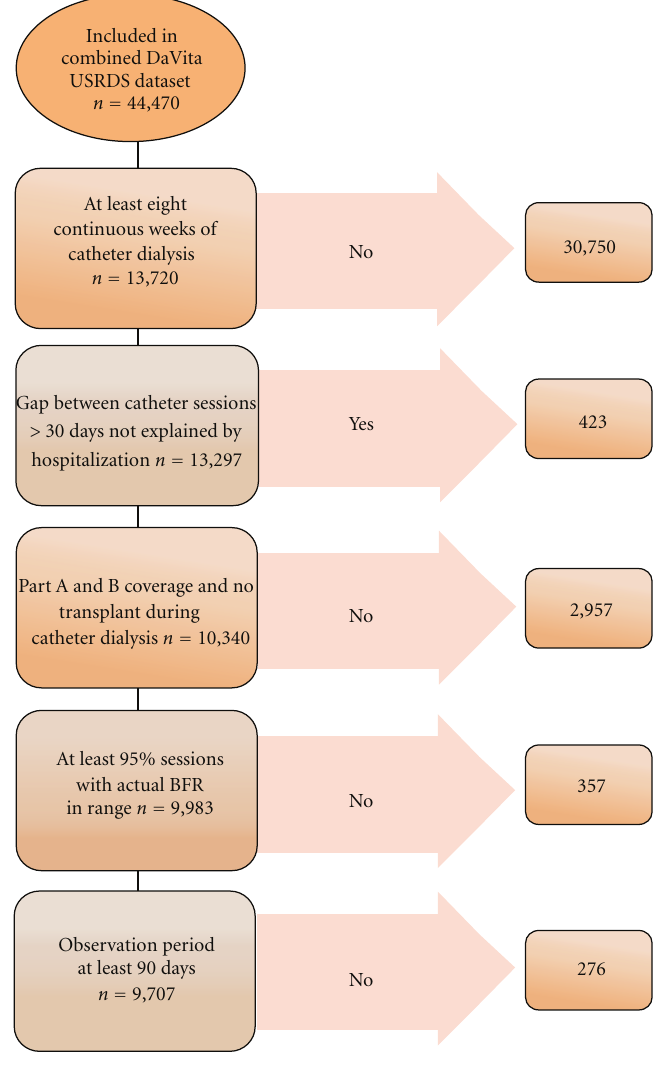
Figure 1: Patient inclusion and exclusion